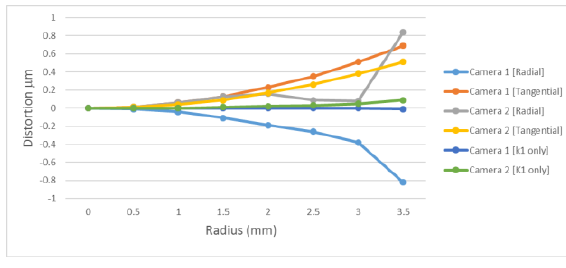
Figure 14. Radial and tangential lens distortion curves for the 10 parameter Camera 1 (Violet) and Camera 2 (Infrared) models. Those marked “K1 only” are from the respective 4 parameter models, each incorporating a single radial term.